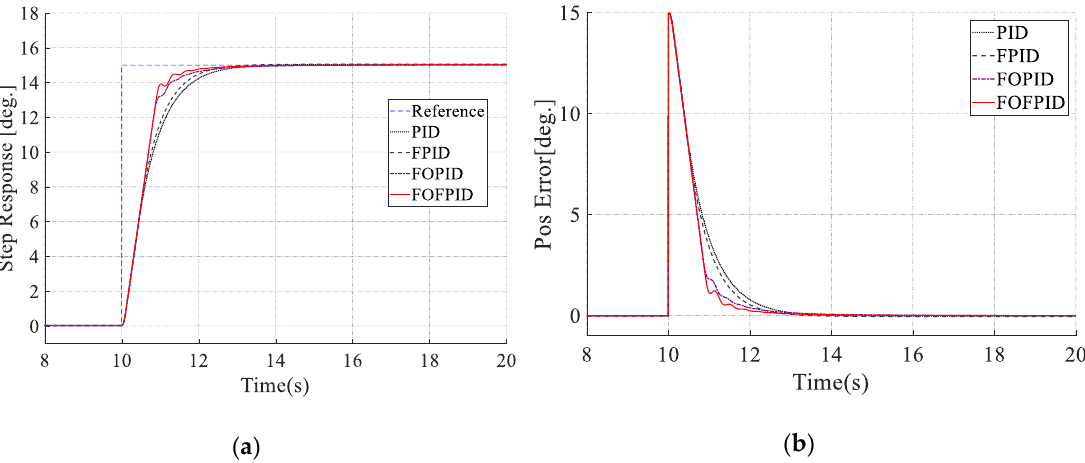
Figure 8. Comparison for step trajectory (amplitude 15 degrees and the payload is 150 N). ( a ) Output performance; ( b ) error effort.